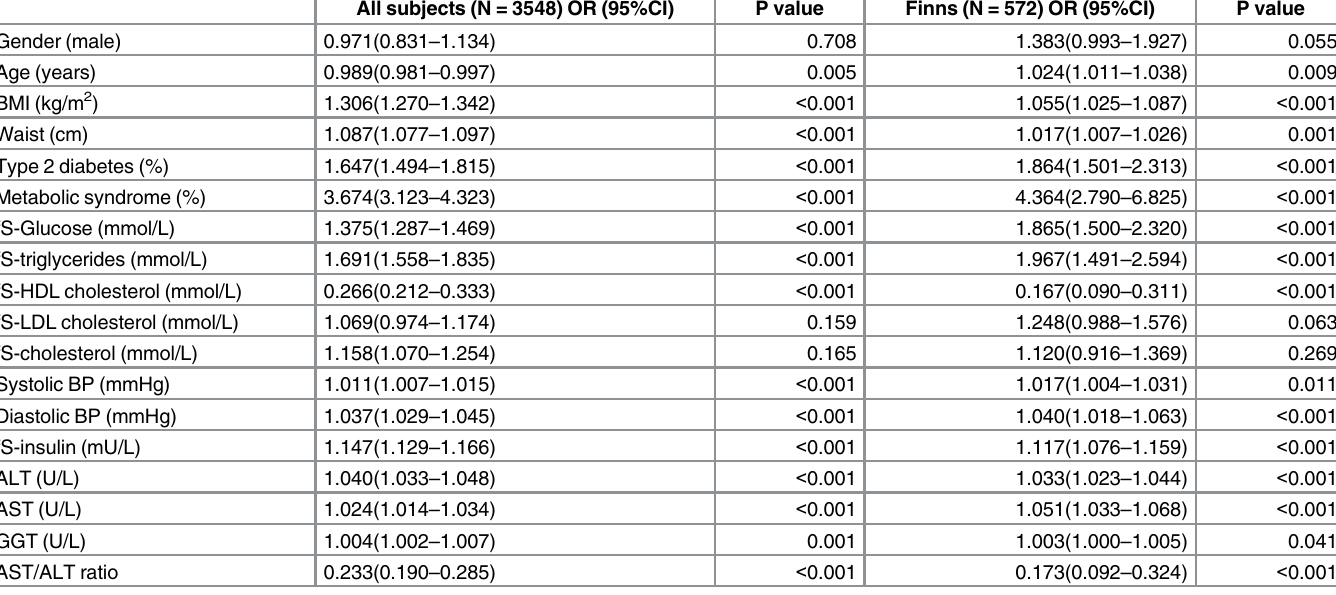
Table 2. Univariate logistic regression showing odds ratios and 95%CI for NAFLD in the Chinese and Finns.